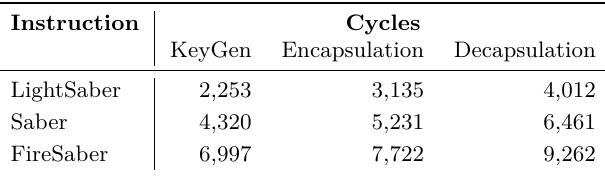
Table 4: Cycle counts for different variants of Saber when each MAC unit fits two